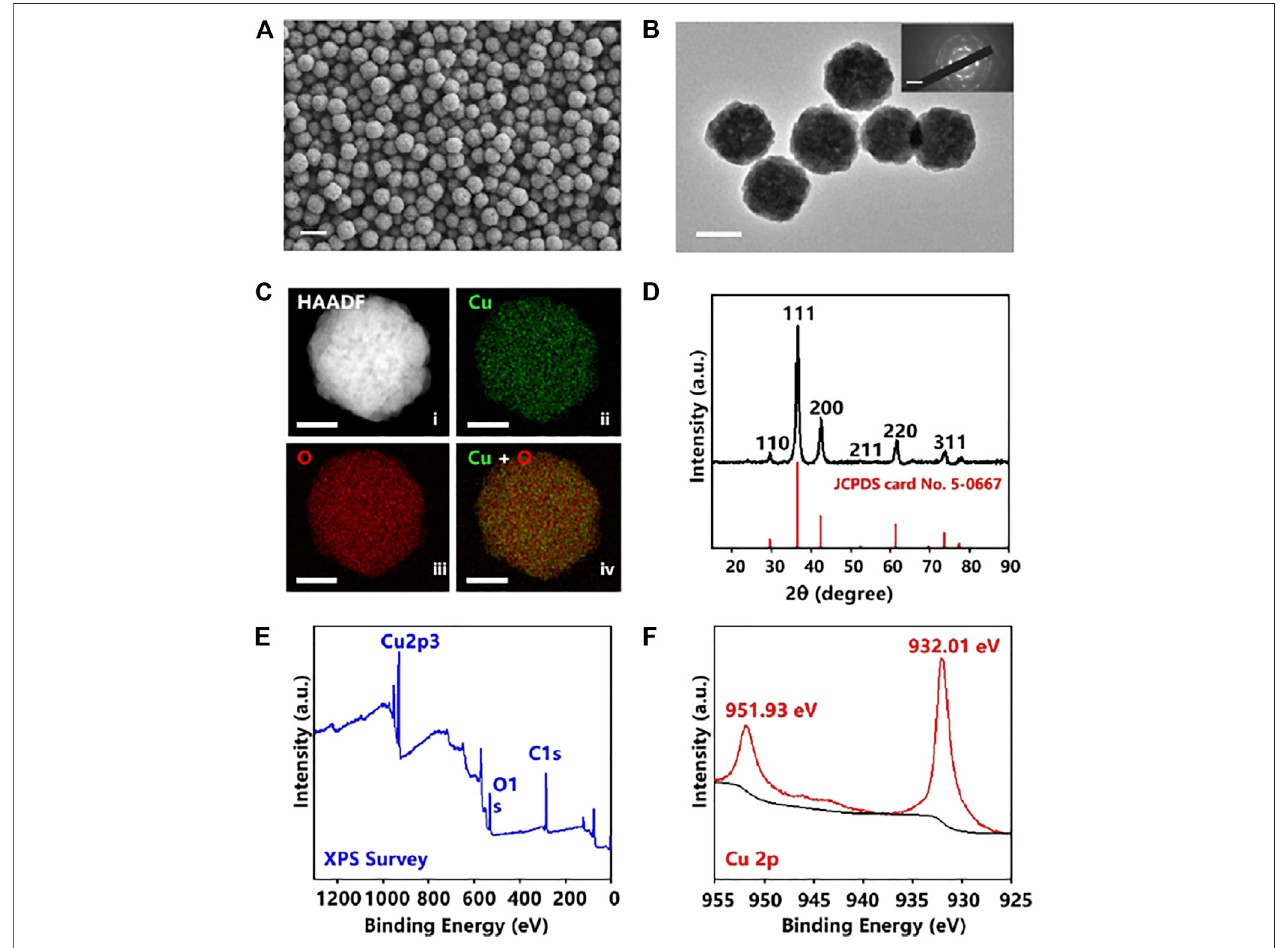
FIGURE1|(A) SEMimagesofCu 2 ONPs.Thescalebaris400 nm. (B) Transmissionelectronmicroscopy(TEM)imageofCu 2 ONPs(n ≥ 3randomlyselected)and selectedareaelectron diffraction(SAED)pattern(inset)showingpolycrystallinestructure.Thescalebaris200 nm. (C) ElementalmappingofCu 2 ONPsshowing(ii)Cuin green, (iii) O in red, and (iv) overlapped Cu + O, with HAADF in (i), Scale bar is 100 nm. (D) XRDpatternof the Cu 2 O NPs. XPS spectra of the Cu 2 O NPs: (E) XPS Survey, and (F) Cu 2p.